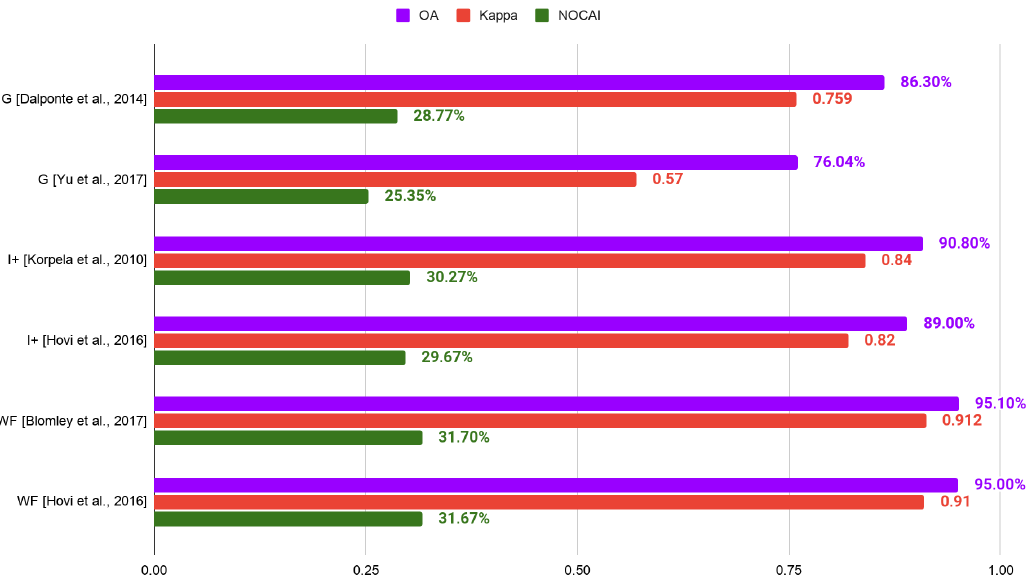
Figure 6. Classification accuracy using overall accuracy, κ coefficient, and NOCAI value of the studies where three tree species were classified with feature group; G— geometry group, I+— intensity+ group, WF— waveform group; the studies of classification results are presented in the square